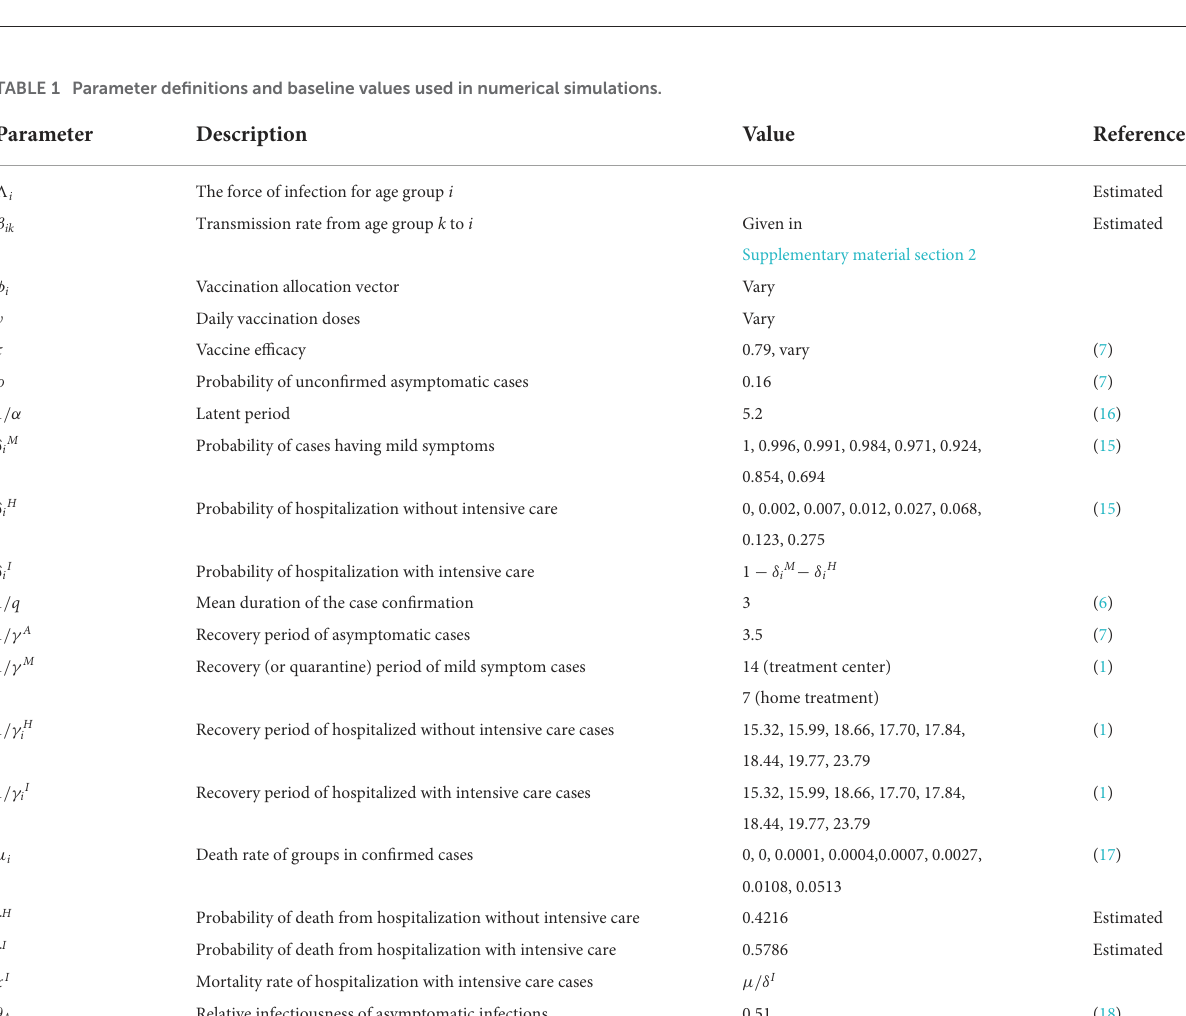
FIGURE2 Schematic diagram for the proposed model.